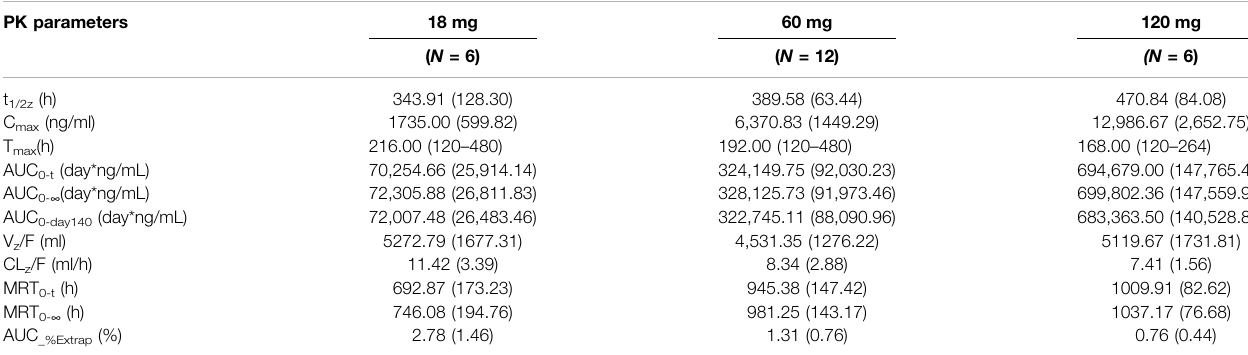
TABLE 4 | Pharmacokinetics parameters of single injection of